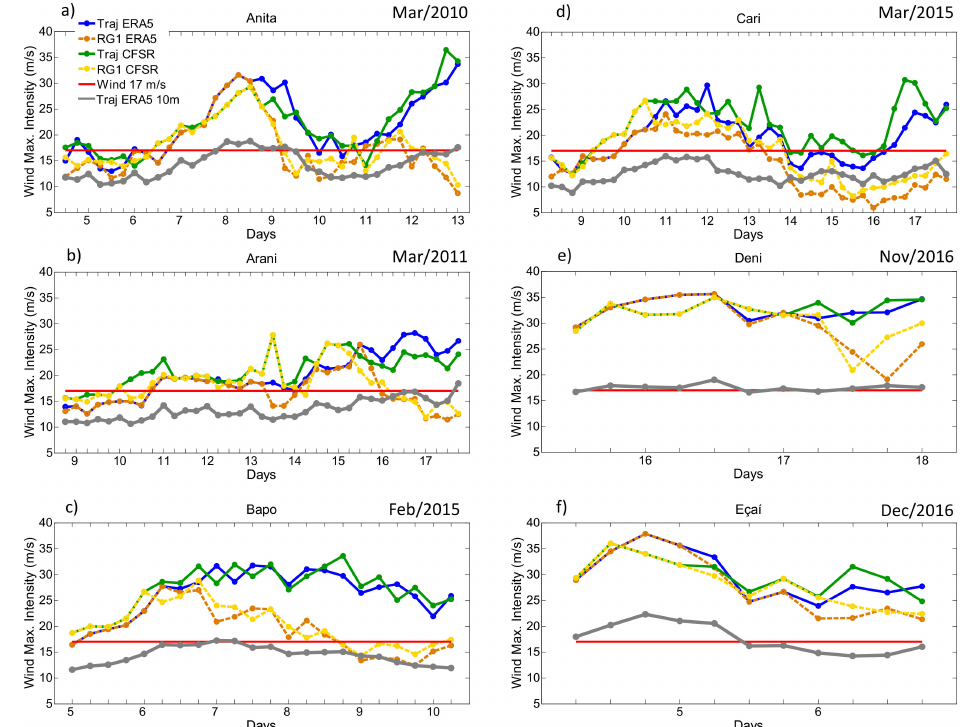
Figure 12. Maximum wind intensity (m · s − 1 ) at 925 hPa every 6 h in a region of 10 ◦ × 10 ◦ following the cyclone center (Lagrangean analysis) for ERA5 (blue line) and Climate Forecast System Reanalysis (CFSR; green line) and maximum wind intensity in RG1 (Eulerian analysis) for ERA5 (orange line) and CFSR (yellow line): ( a ) Anita, ( b ) Arani, ( c ) Bapo, ( d ) Cari, ( e ) Deni and ( f ) Eça í . The maximum 10-m winds following the cyclone center are also presented for ERA5 (grey line). The horizontal red line indicates the intensity of 17 m · s − 1 , which is a threshold used by Reference [19] to consider a cyclone as subtropical at 925